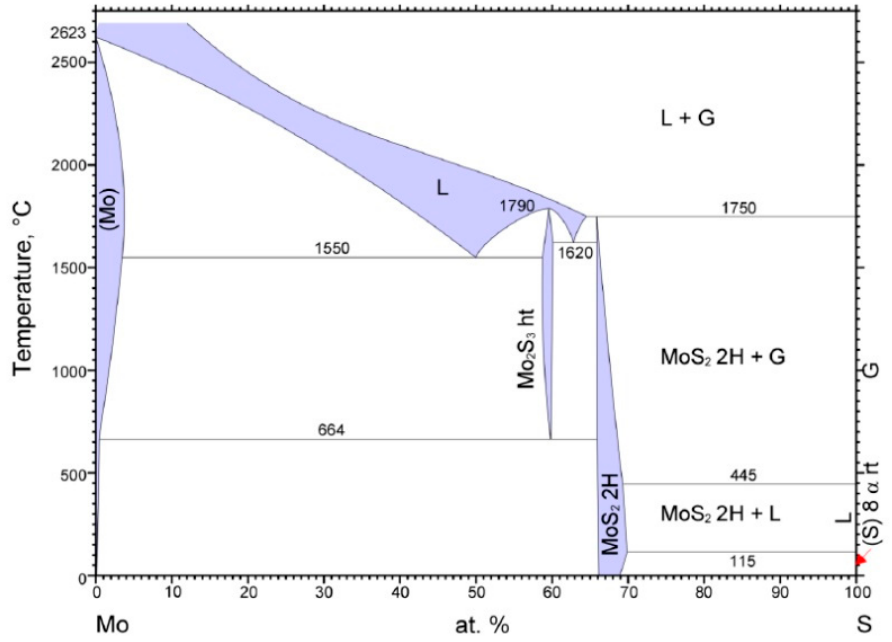
Figure 1. Phase diagram of Mo-S system.